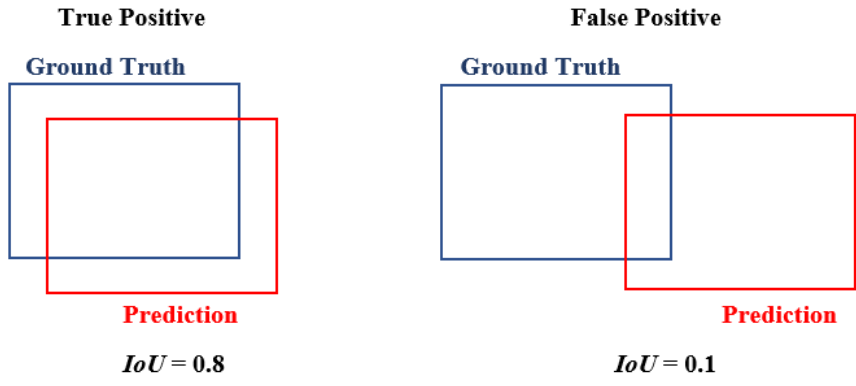
Figure 9. Example of true and false positives.